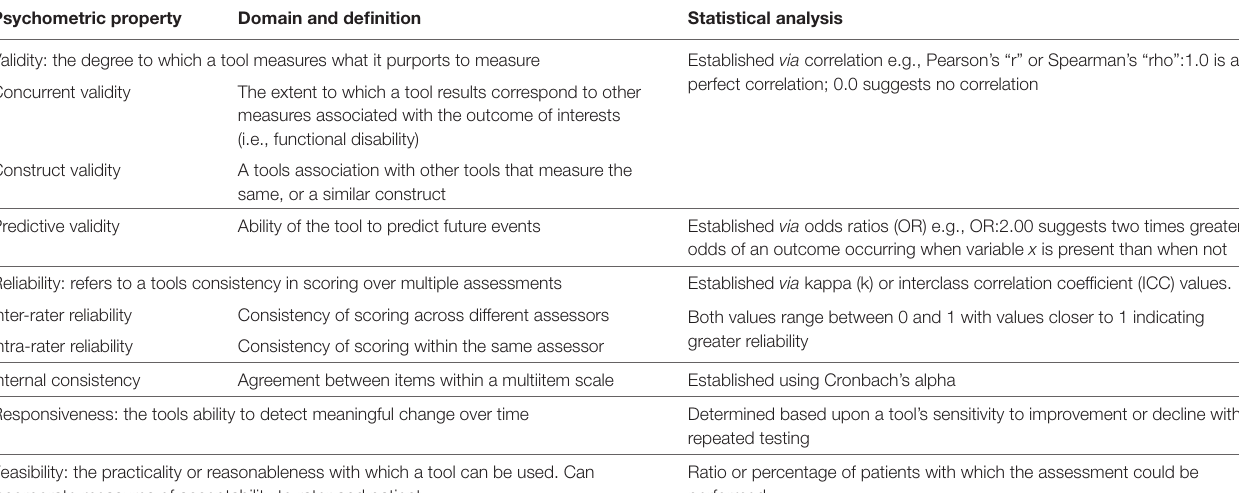
TABle 1 | Core psychometric properties and how we evaluate